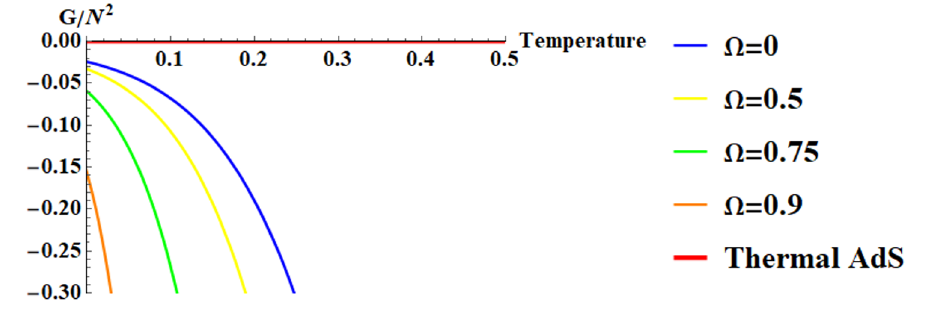
Figure 5 . The free energy G when Φ = 3 . 5 . The angular velocities Ω a = Ω b = 0 , 0 . 5 , 0 . 75 , 0 . 9 increase from right to